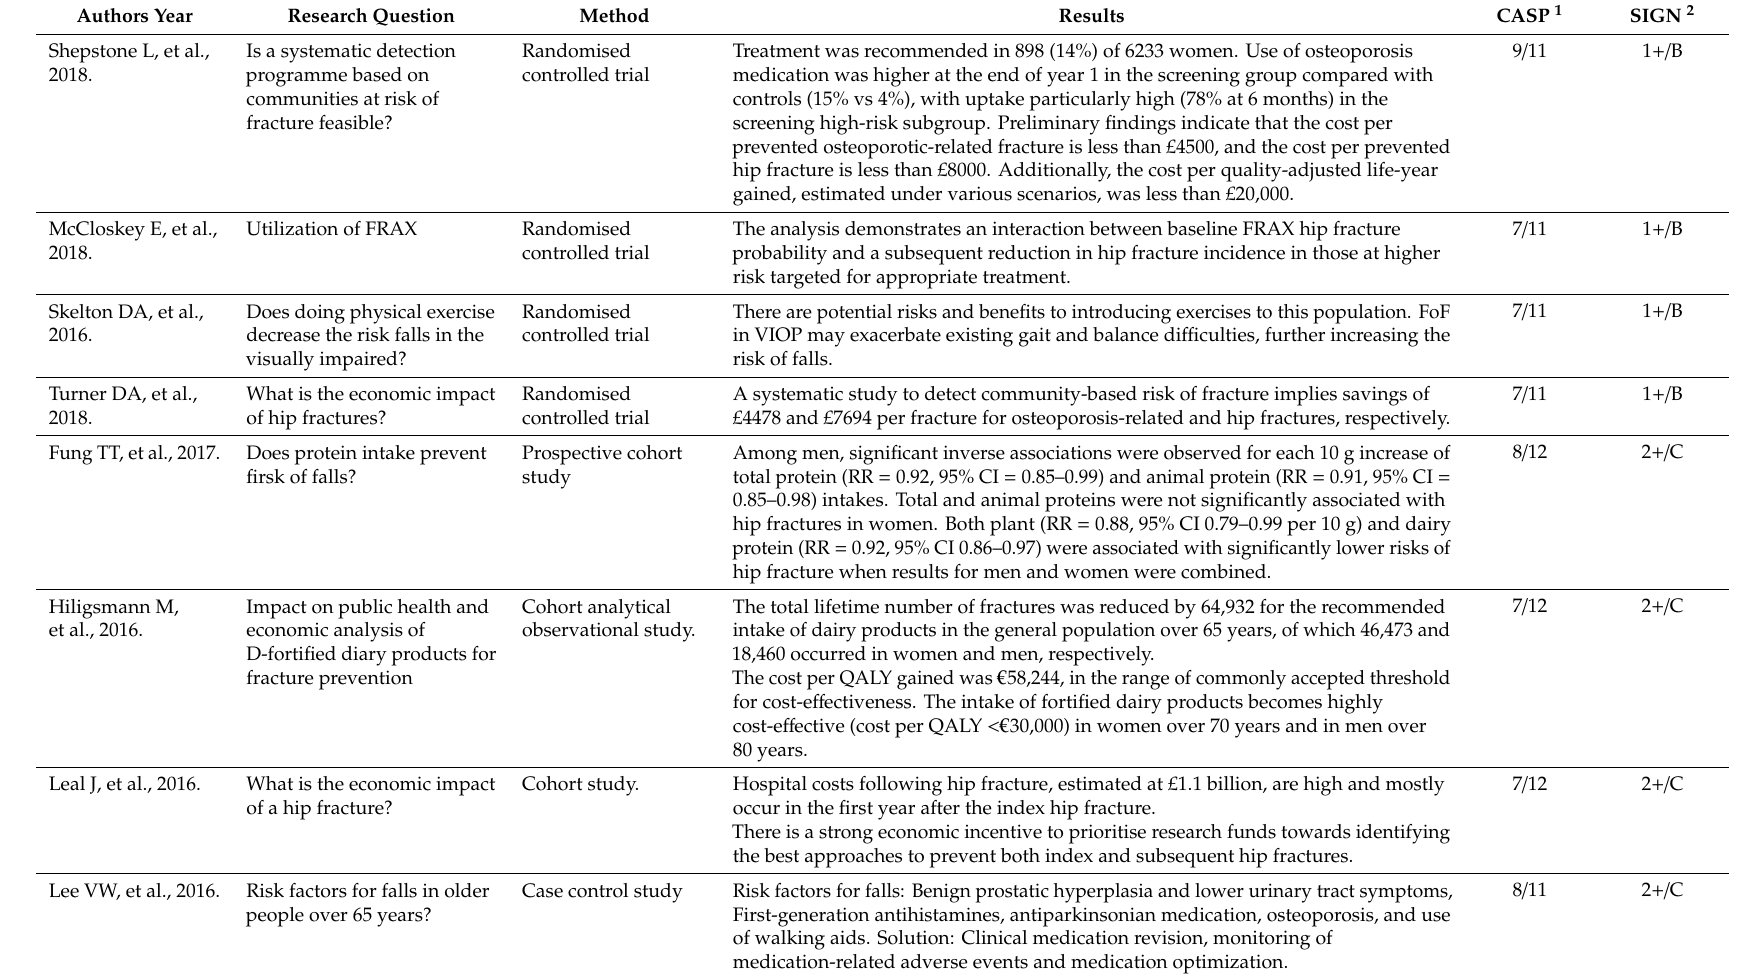
Table 3. Results from clinical